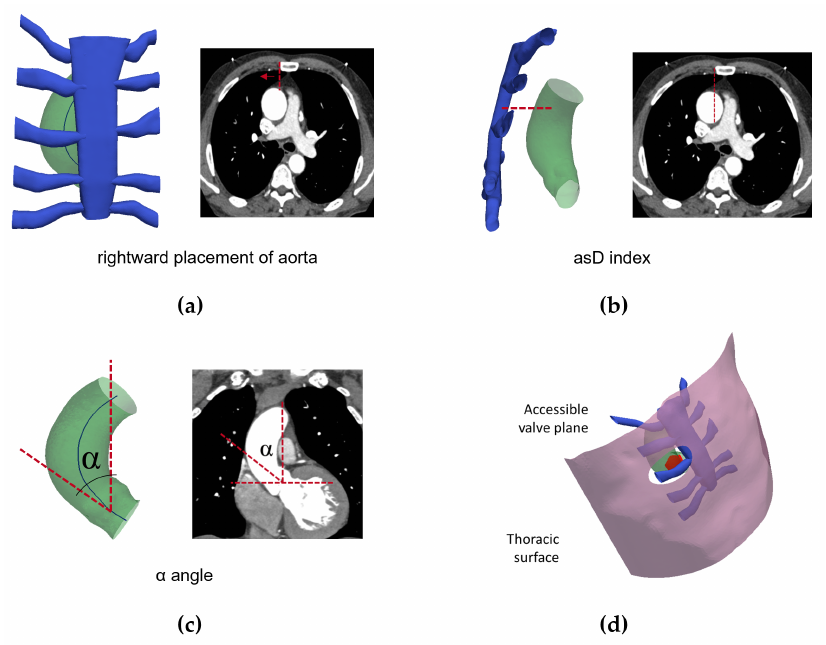
Figure 2. RT inclusion criteria evaluation ( a – c ) and a patient-specific virtual “planning/surgery” ( d